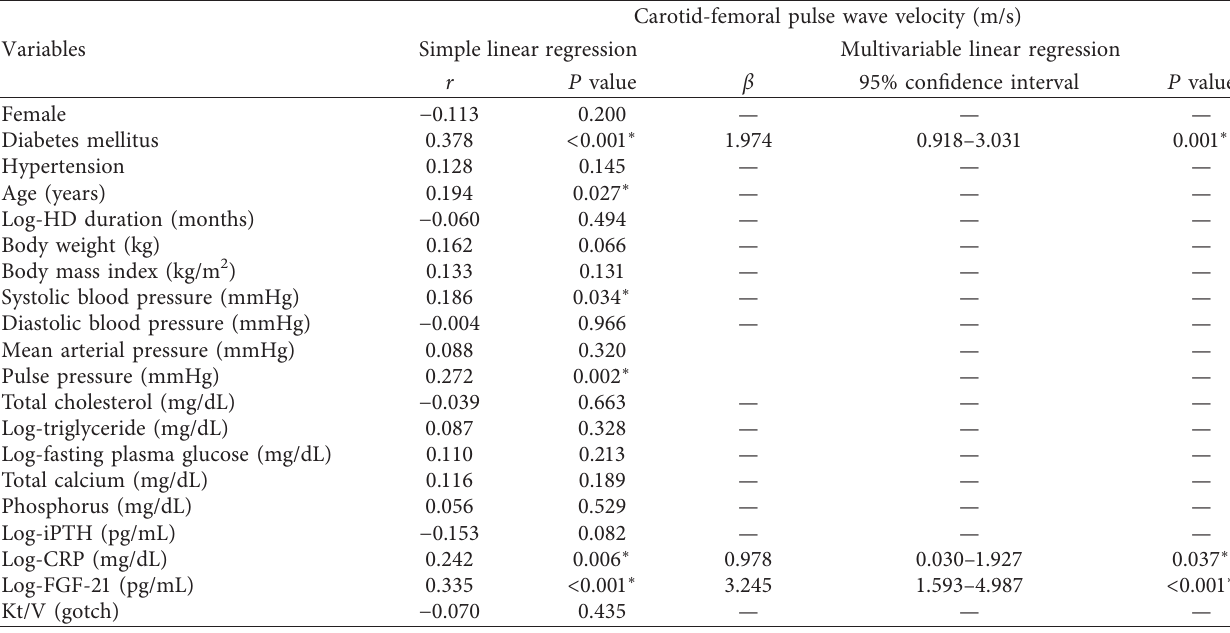
The data of HD duration, triglyceride, fasting plasma glucose, iPTH, CRP, and FGF-21 levels showed skewed distribution and therefore were log-transformed before analysis. Analysis of data was performed using the simple linear regression analysis or multivariate stepwise linear regression analysis (adopted factors: diabetes mellitus, age, systolic blood pressure, pulse pressure, log-CRP, and log-FGF-21). HD, hemodialysis; iPTH, intact parathyroid hormone; CRP, C- reactive protein; FGF-21, fibroblast growth factor 21; Kt/V, fractional clearance index for urea; β , unstandardized regression coefficient. ∗ P < 0 . 05 was considered statistically